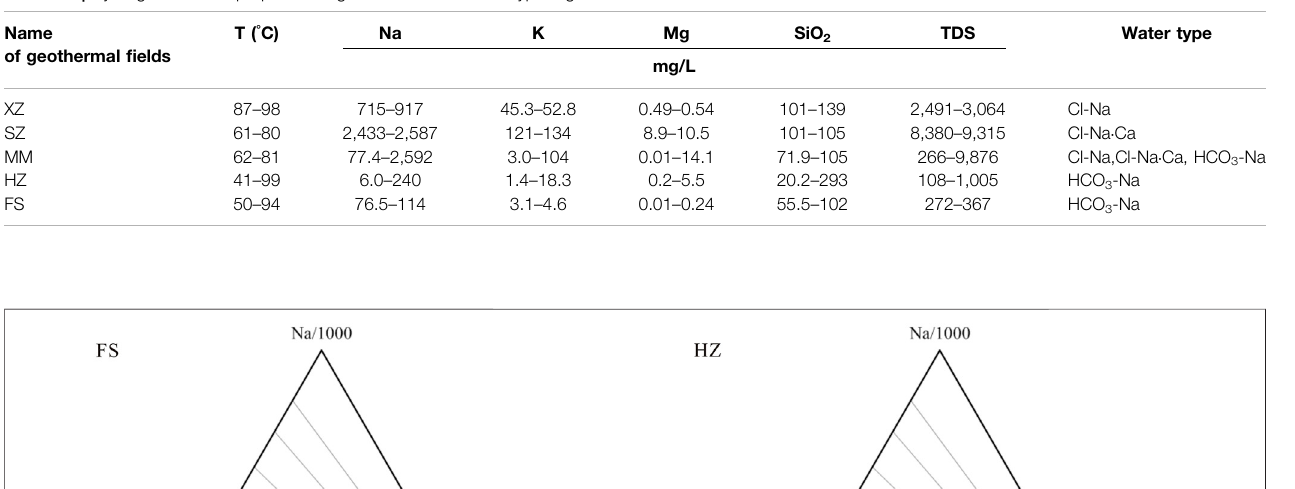
Frontiers in Earth Science |